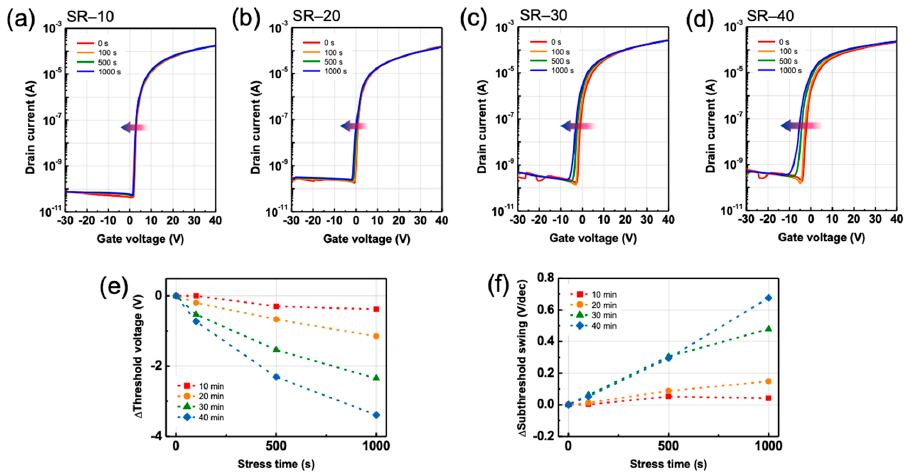
Figure 5. Transfer characteristics as a function of a negative-bias stress time for ZTO TFT specimens: ( a ) SR-10, ( b ) SR-20, ( c ) SR-30, and ( d ) SR-40. ( e ) Threshold voltage and ( f ) subthreshold swing shift of ZTO TFTs for a negative-bias